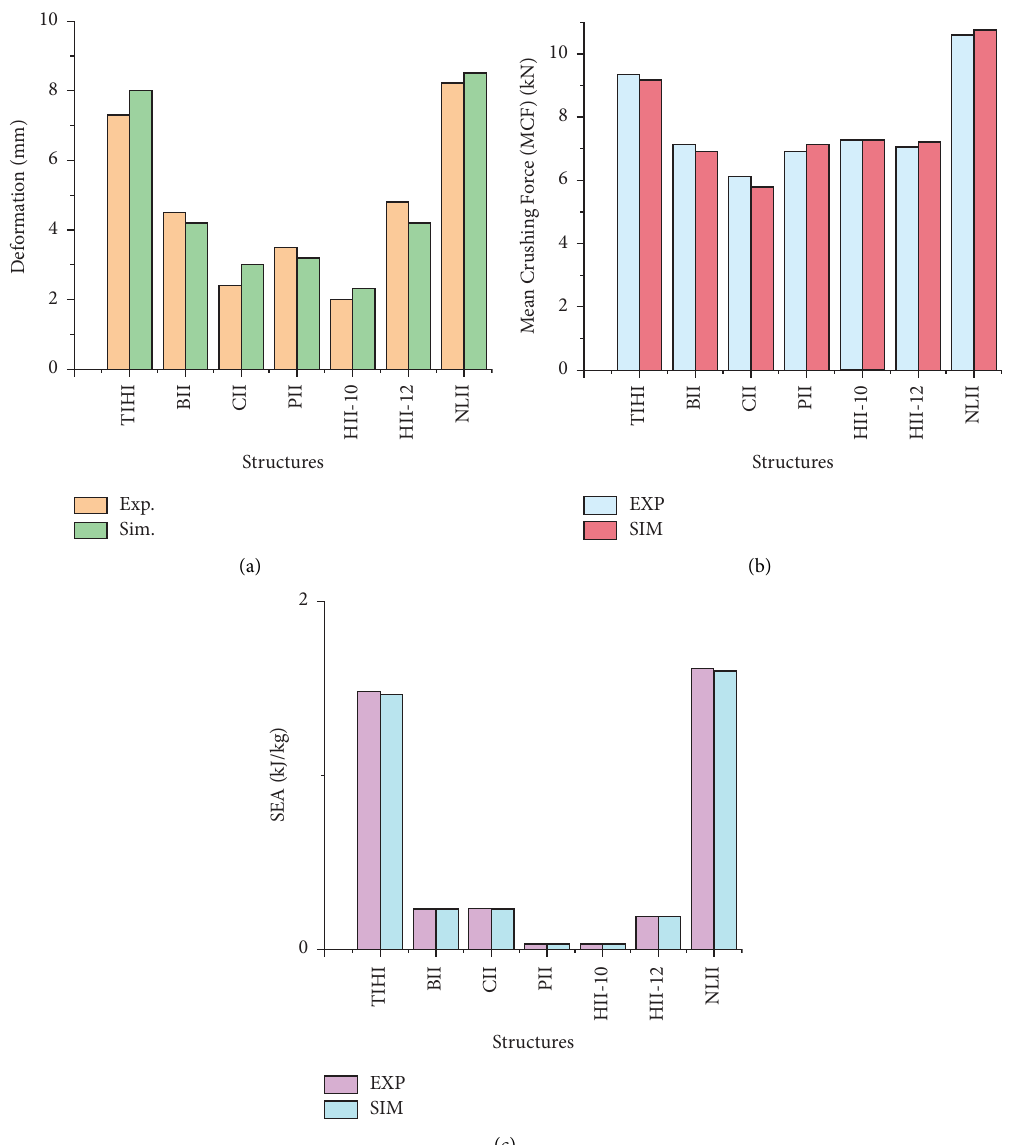
Figure 10: Comparison of experimentation and simulation results for all structures: (a) deformation, (b) MCF, and (c)